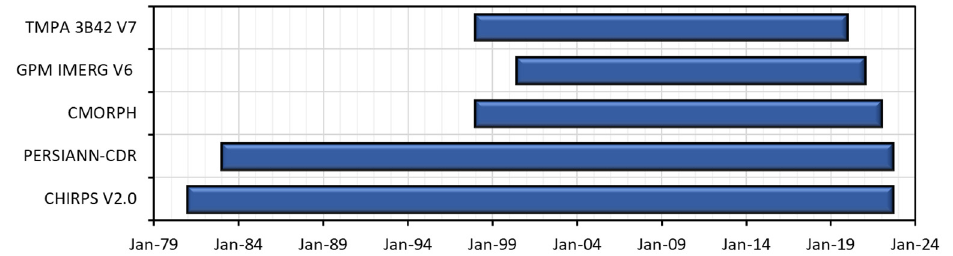
Figure 2. The time coverage for each satellite-based precipitation dataset (SPDS).